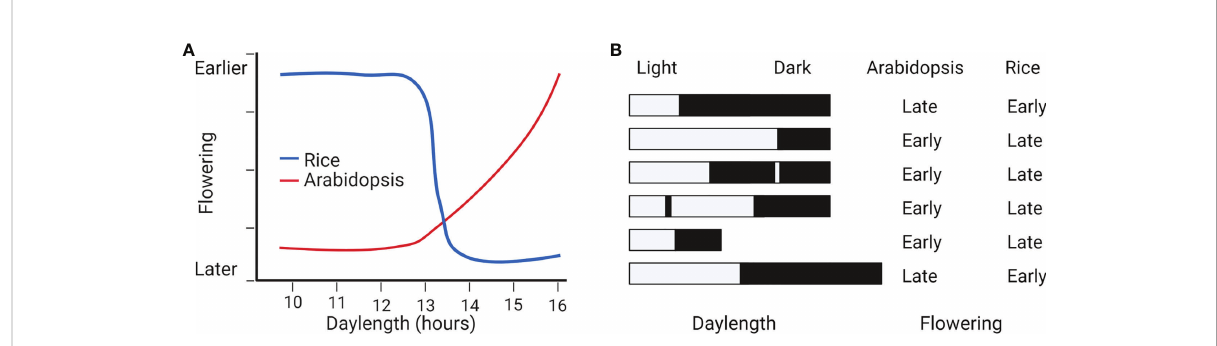
FIGURE 1 Different photoperiod and NB responses between SDP rice and LDP Arabidopsis. (A) Opposite responses to photoperiod in rice and Arabidopsis. Flowering in Arabidopsis gradually becomes earlier with increasing day length. However, rice has a ≈ 13.5 h CDL and detects changes of 15 minutes for fl owering transition. (B) Effect of dark length to fl owering in rice and Arabidopsis. Rice fl owering is early in the long dark. Arabidopsis fl owering is early in long day or short dark. NB treatment induces fl owering in Arabidopsis but suppresses fl owering in rice (Thomas and Vince- Prue,